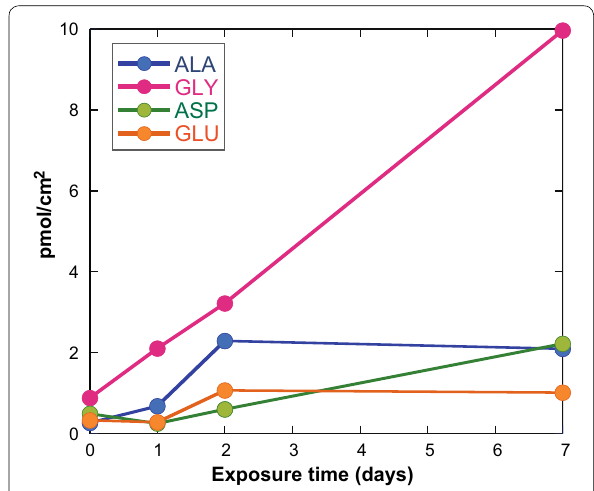
Fig. 5 A time-course profile up to 7 days of selected amino acids common to all of the witness coupons. The result of the day 31 witness coupon, which is not plotted, showed a similar value to that of the day 1